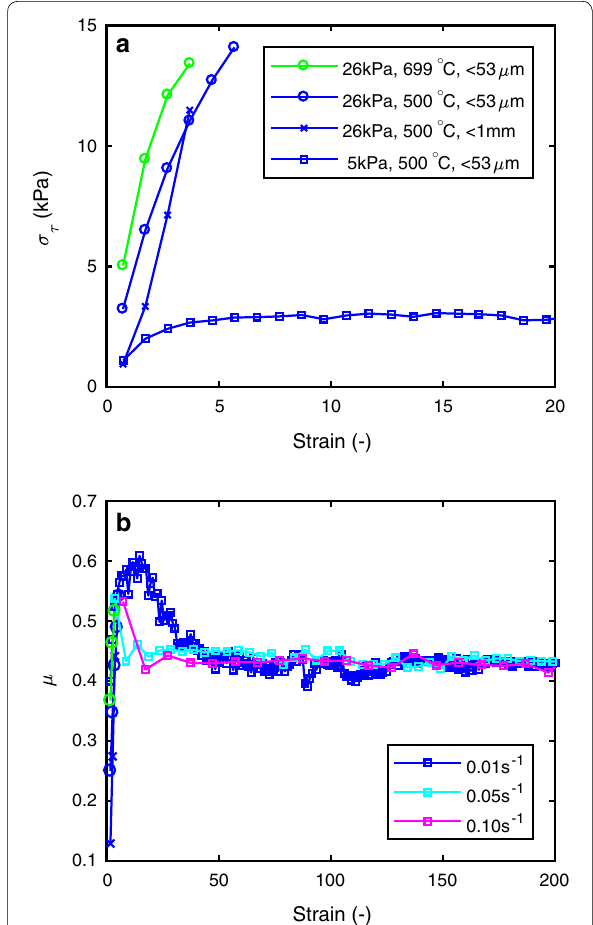
Fig. 10 a Stress and b friction coefficient of ash measured by steady shear deformation. a Shear stresses measured under one-directional rotation with a shear rate of 0.01s − 1 at various normal stresses, temperatures, and grain sizes. b Friction coefficient as a function of the strain and shear